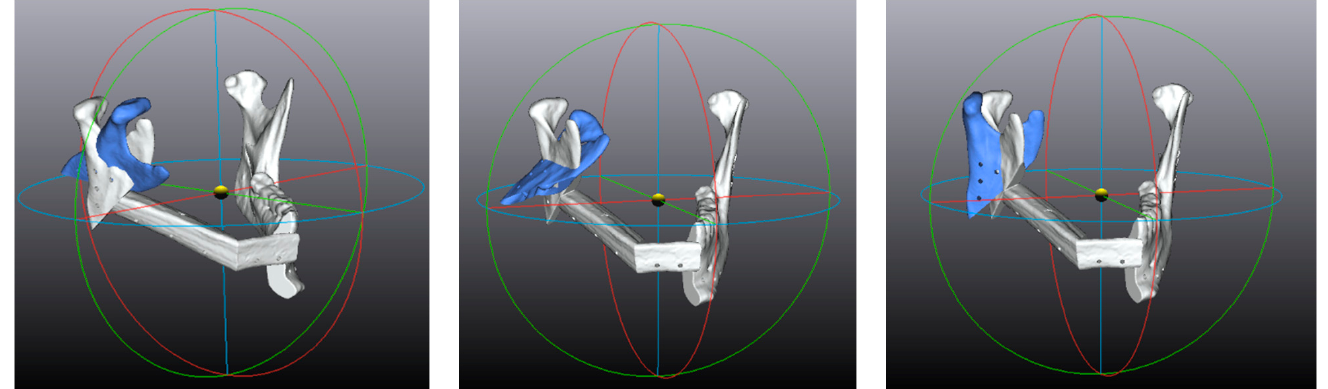
Figure 6. Examples of translation angles obtained with arbitrary values (50°): from left to right, pitch, roll, and yaw.